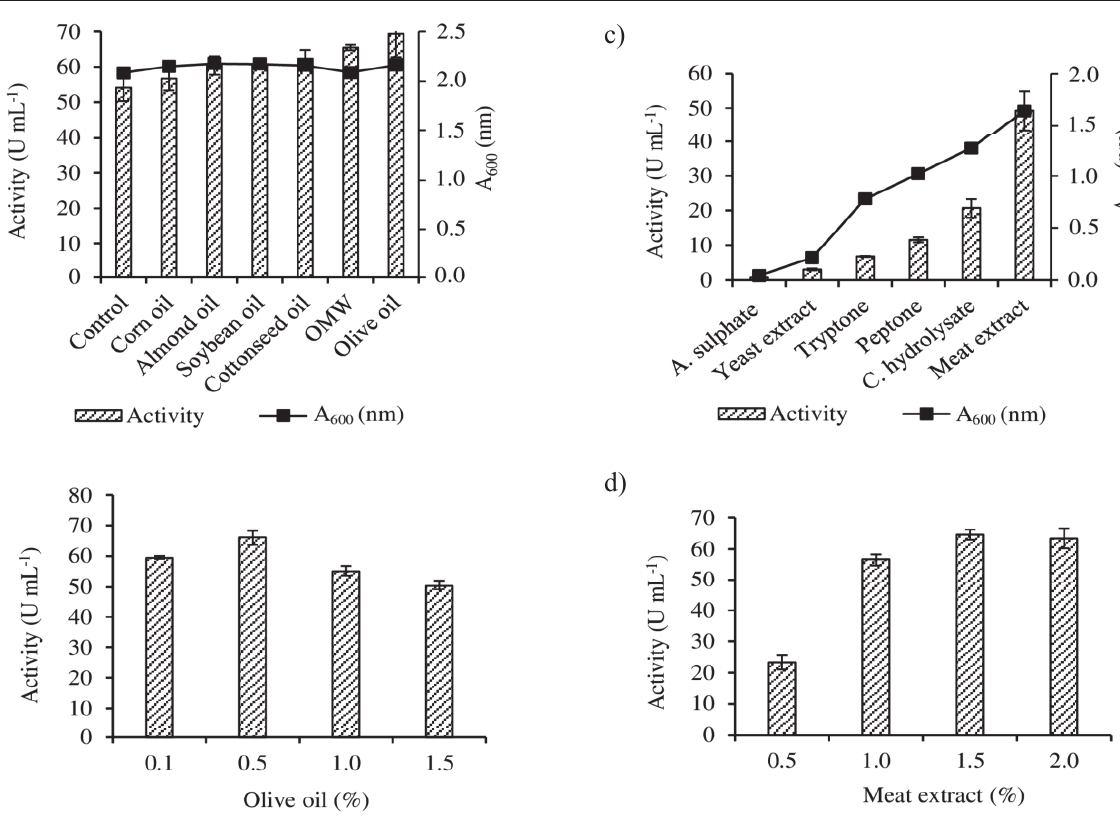
Fig. 3 Effect of carbon and nitrogen sources on lipase production a) Anoxybacillus sp. HBB16 was grown at 50 ° C and pH 6.5 for 24 h on LB medium containing 0.5 % gum